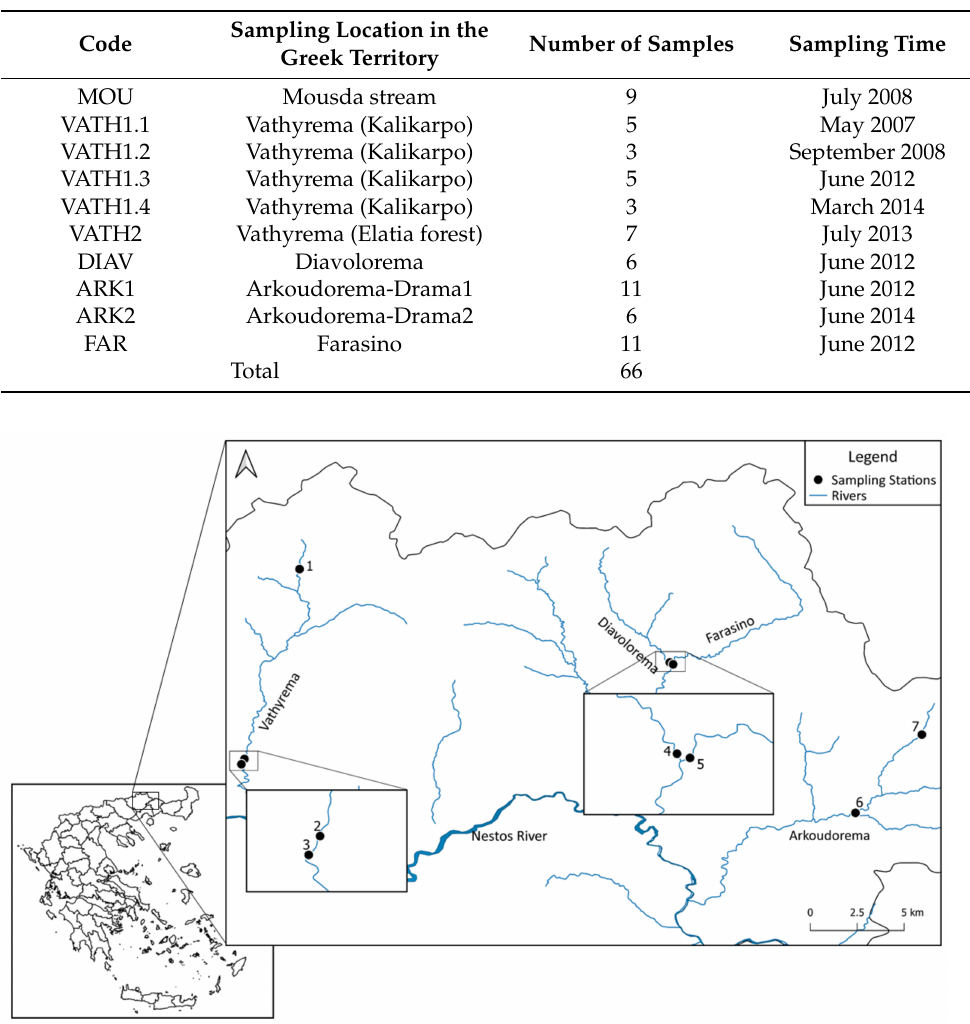
Table 1. Sample collection information.